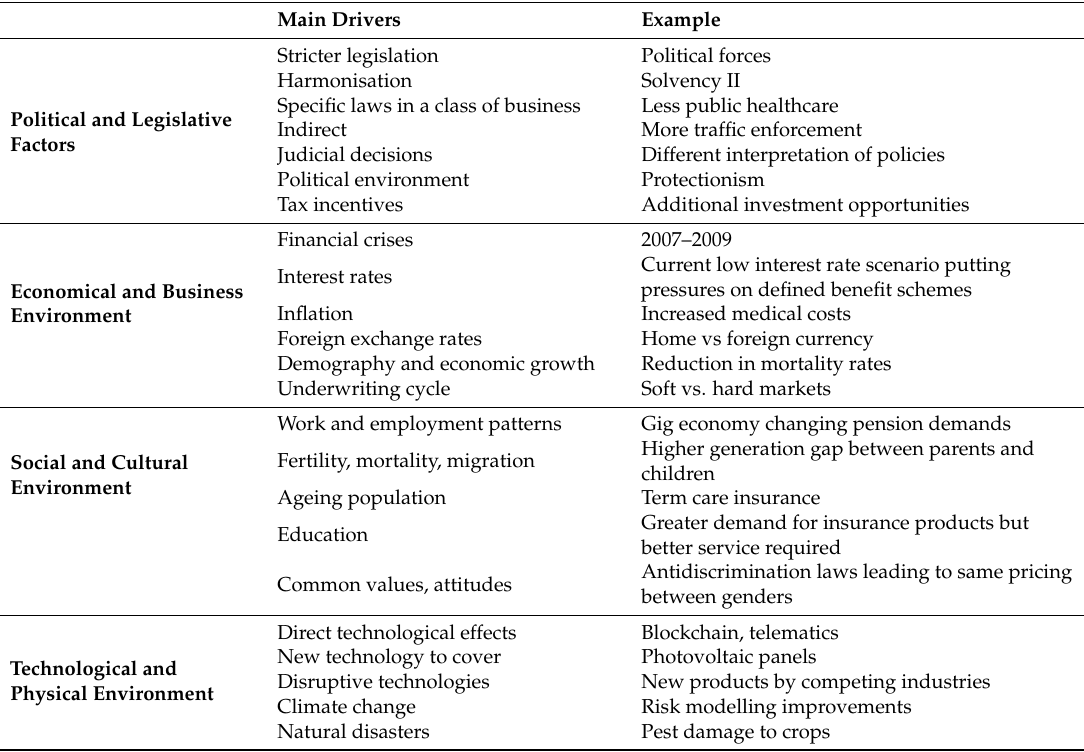
Table 1. Summary of main